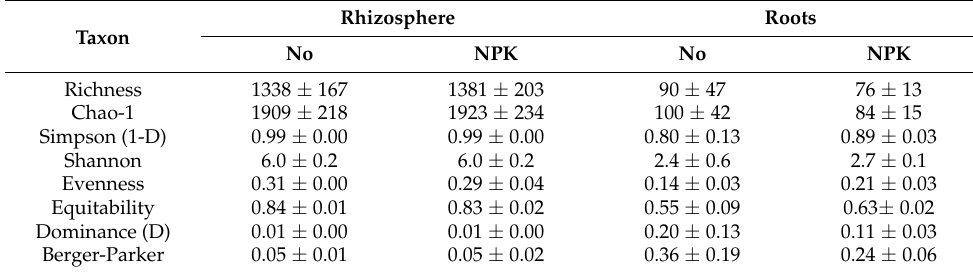
Table 3. Alpha-biodiversity indices (mean ± standard deviation) of the rhizosphere and root bacteri- obiome of tomato plants grown in the open field in the south of West